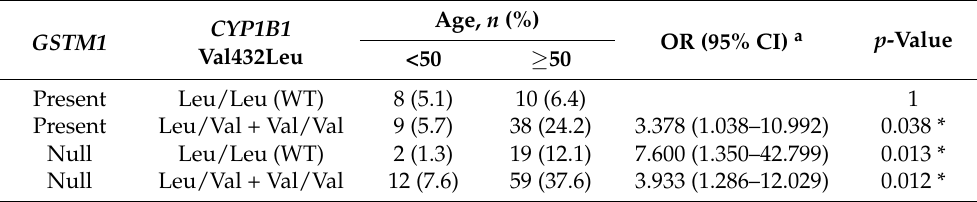
Table 5. Association between GSTM1 and CYP1B1 Val432Leu genotypes combination and patient age at diagnosis of breast